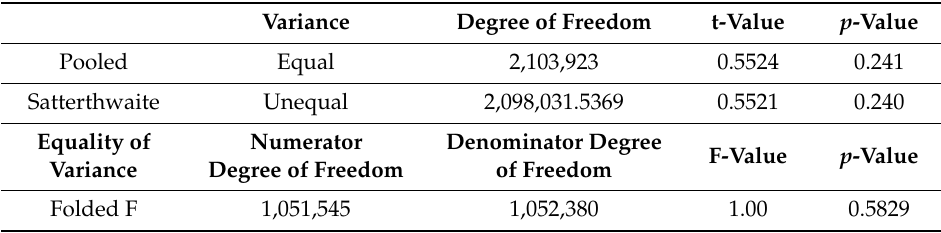
Table 16. Two-sample t -test for